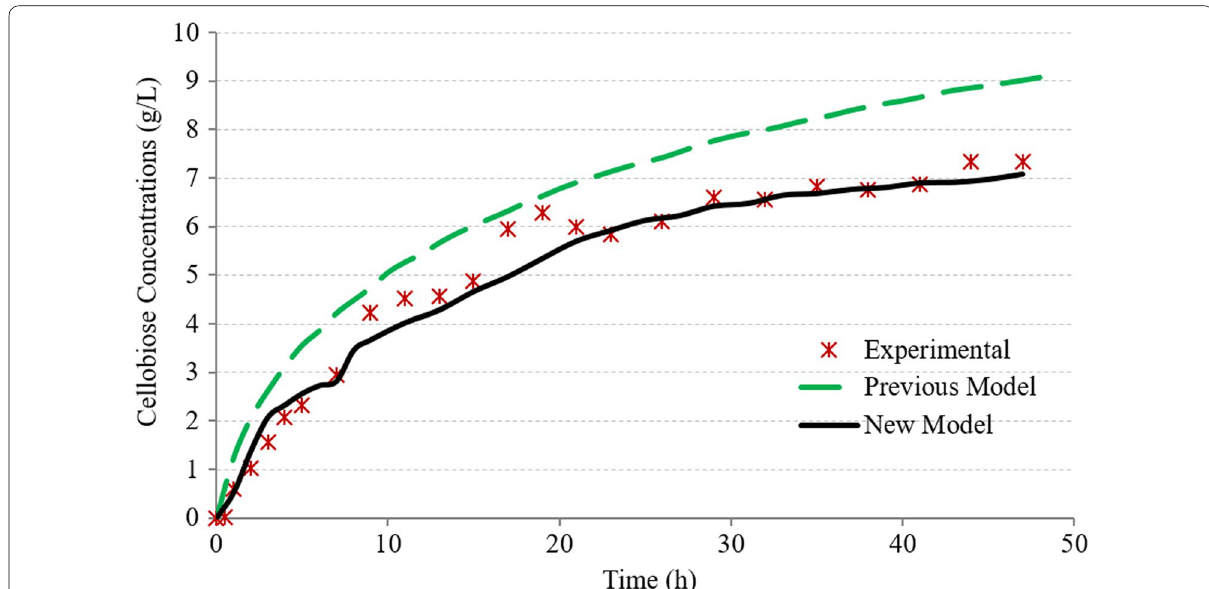
Fig. 6 Comparison of model simulations (current and previous version) and experimental data of cellobiose production during hydrolysis of Avicel (50 g/L) at 20 mg/g cellulose loading. The data points are from literature studies (Bezerra and Dias 2004; Bezerra et al. 2011), solid lines are from the new model predictions, and dotted lines are for predictions from previous version of model